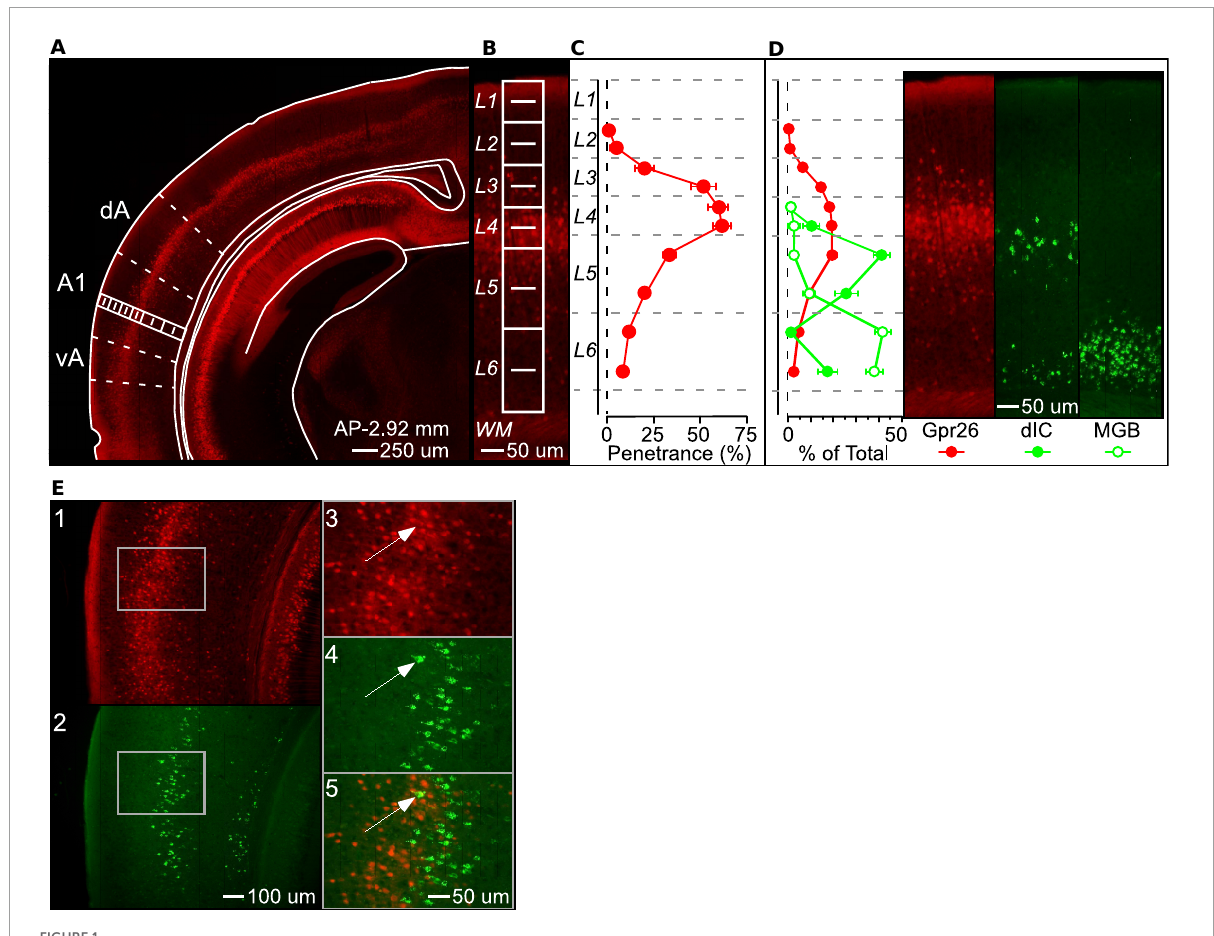
FIGURE1 Gpr26 cells form a dense band in layer 4 of auditory cortex. (A) We visualized Gpr26 expression by crossing the Gpr26-Cre driver line to a Cre-dependent Td-tomato fluorescent reporter line. 25X magnification. (B) To quantify penetrance, we counted Td-tomato labeled cells in a rectangular region (in white) extending from the pial surface through layer 6 of primary auditory cortex (A1), with layers subdivided into two equal halves for increased granularity. Laminar divisions were adapted from Anderson et al. (2009). In situ hybridization enabled visualization and quantification of Ca2 + /calmodulin-dependent protein kinase II positive (CaMKII +) excitatory neurons (not shown). Penetrance was defined as the ratio of Gpr26 to CaMKII + cells. 100X magnification. (C) Penetrance was greatest in layer 4 (62%), and included 52% of excitatory cells across middle layers 3b-5a. (D) Fluorescent retrobeads injected into dorsal inferior colliculus (dIC) and the medial geniculate body of the thalamus (MGB) labeled cortical output neurons in layers 5&6. Percentages reflect the proportion of labeled cells in each laminar subdivision relative to the total number of labeled cells across subdivisions, for each group. 100X magnification. (E) Co-localization of Gpr26-tdTomato and dIC-injected retrobead fluorescence was limited to approximately 1% of cells across layers 4b-5b, the layers of greatest overlap of the two populations. To determine the extent to which Gpr26 neurons contributed to the dIC projection, fluorescent Gpr26 (panel 1) and dIC-projecting (panel 2) neurons were counted across layers 4b-5b of A1. Images were then merged to quantify co-localization of identified neurons from the two channels. As illustrated, cells fluorescing in both the Td-tomato red (panel 3) and retrobead green (panel 4) channels would appear yellow (panel 5) when merged (see arrow). 50X and 100X magnification. dA and vA, dorsal and ventral auditory cortex fields; WM, white matter. Coronal outlines adapted from Paxinos and Franklin (2004). Plots show mean ±